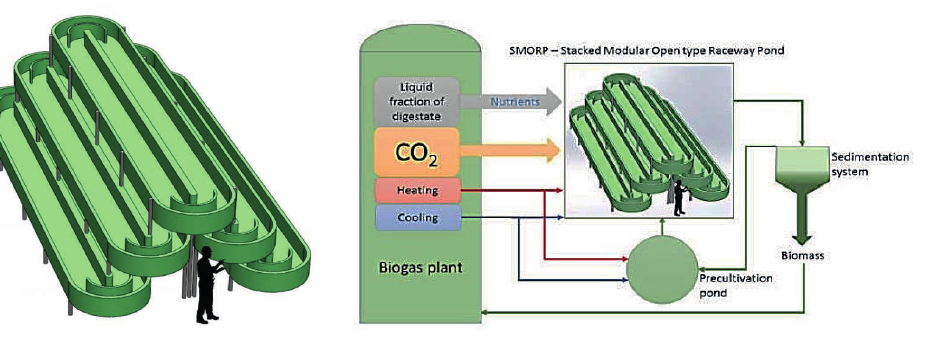
Fig. 1. Concept system of stacked ponds Fig. 2. SMORP pilot plant coupled with a biogas plant. at the pre-commercial